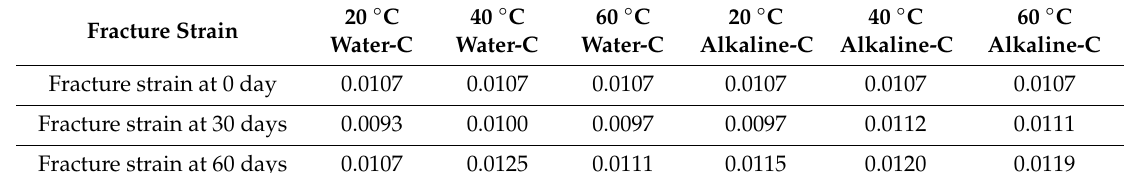
Table 5. Fracture strain of coated immersed specimens.